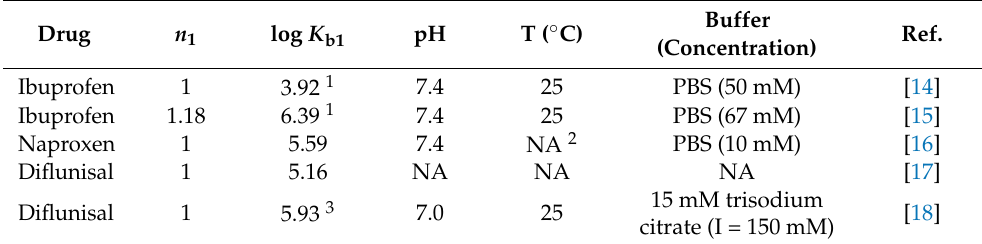
Table 5. Stoichiometry and binding constants were reported in the literature for the NSAIDs interac- tions with HSA using molecular